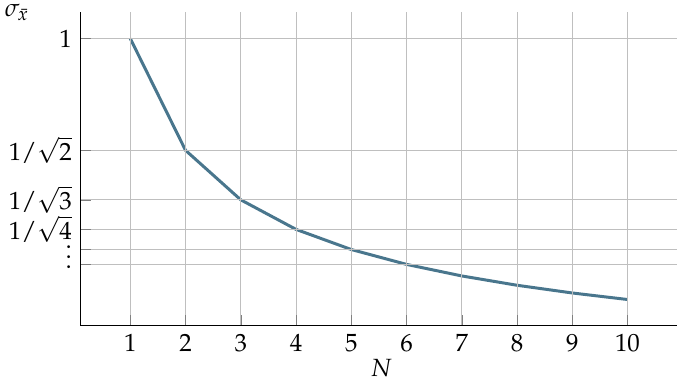
Figure 2. Standard error for estimating actual position with increasing number of